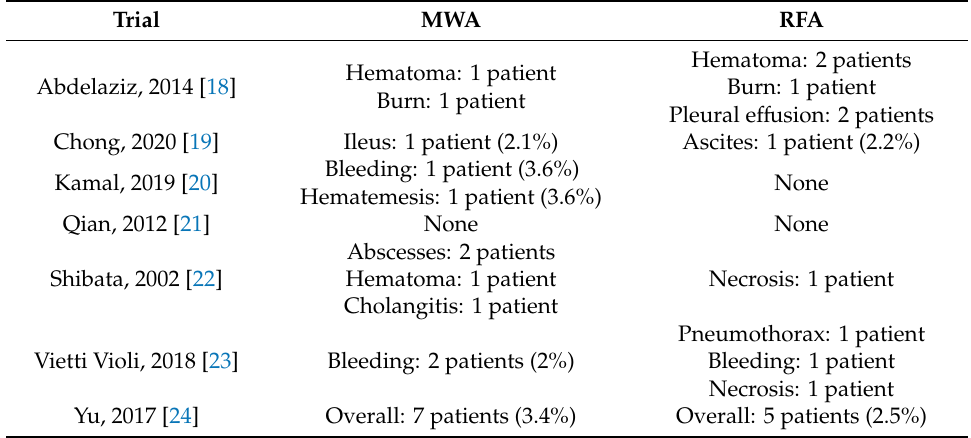
Table 4. Adverse events reported in the included